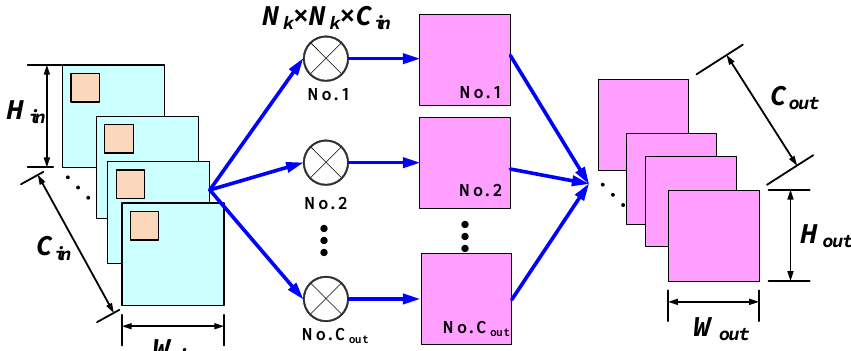
Figure 2. The convolution procedure of a standard convolution layer. Given a W in × H in × C in feature map F in with W in × H in being the spatial size and C in being the number of channels of the input feature map, respectively, the standard convolution layer utilized C out trainable convolution kernels whose size is N k × N k × C in to produce the W out × H out × C out feature map F out with W out × H out being the spatial size and C out being the number of channels of F out , respectively.